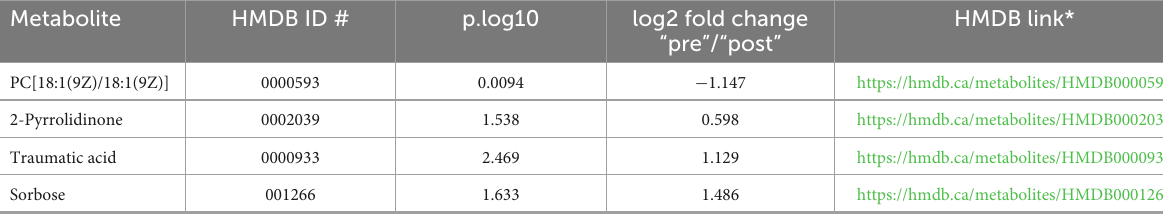
TABLE 4 Summary of metabolites that increased after Ramadan